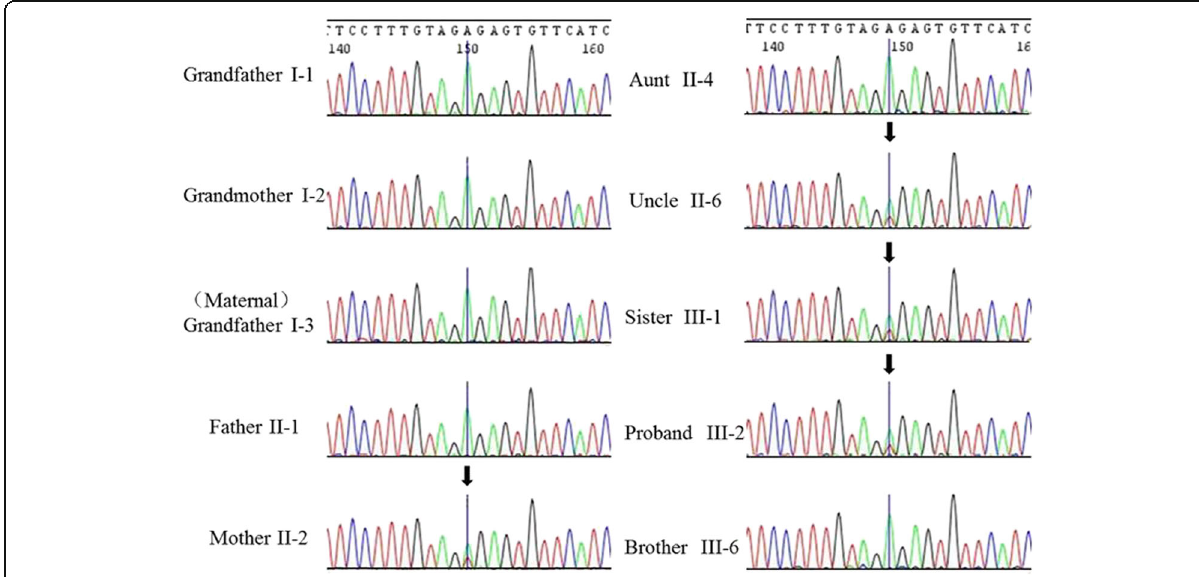
Fig. 4 EYA1 gene test in this family revealed a novel heterozygous nonsense variation (c.967A> T; p: Arg323X) in exon 11 in members with various physical anomalies (II:2, III:6, III:1, and III:2) (arrow). The normal family members harbored no mutations in